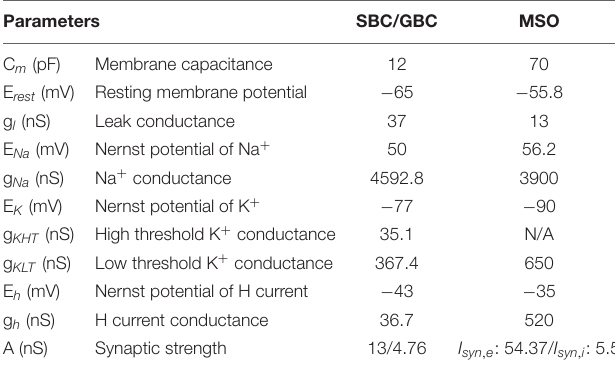
TABLE 1 | Parameters for spherical bushy cells (SBC), globular bushy cells (GBC), and medial superior olive (MSO)